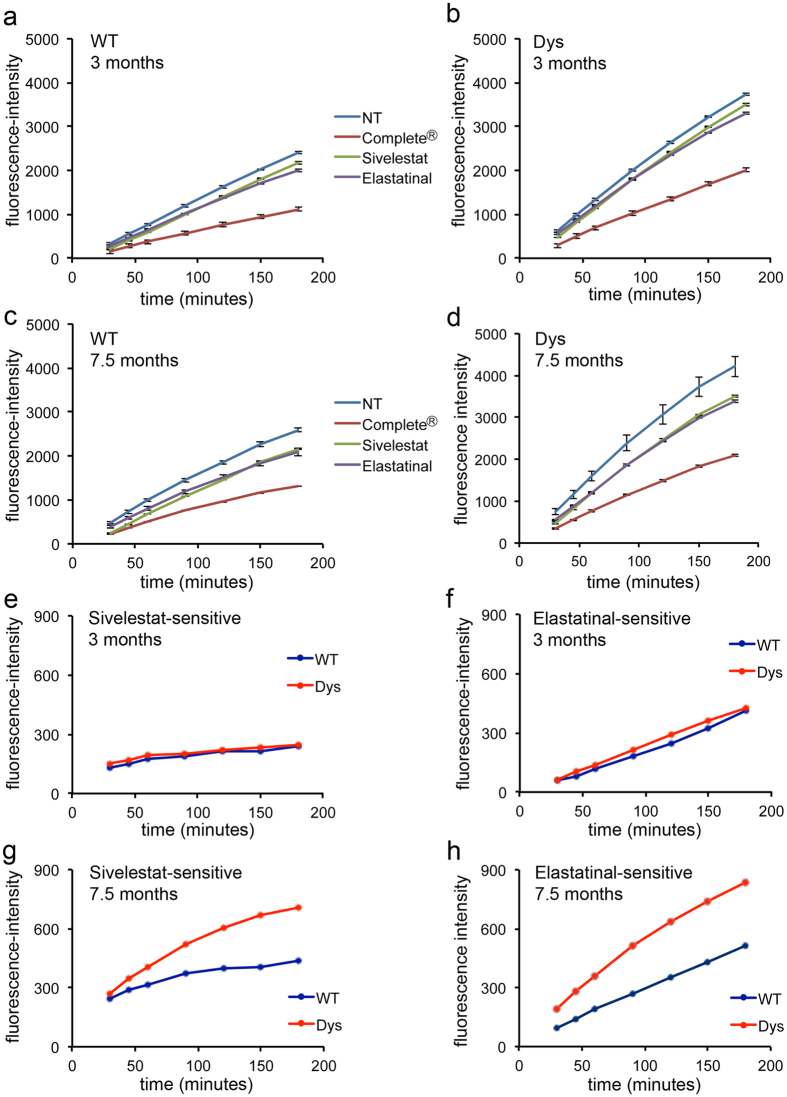
Elastase activity is increased in 7.5 month-old dystrophic muscle compared to age-matched wild type muscle.(a–d) Protease activity against the elastase substrate Suc-Ala-Ala-Ala-AMC was measured in the homogenate of wild type and dystrophic quadriceps muscles, in the presence/absence of various protease inhibitors, for each age and genotype group: 3 month old (a,b) and 7.5 month old (c,d), wild type (WT, a,c) and dystrophic (Dys, b,d) muscle. Kinetics of the accumulation of the reaction product over time (calculated as fluorescence emitted by each sample–fluorescence emitted by a blank containing only buffer and fluorogenic peptide) was plotted as the average of 3 technical replicates from 4 pooled biological replicates. Error bars are S.E.M. (e–h) The fraction of enzymatic activity against Suc-Ala-Ala-Ala-AMC that was sensitive to the elastase inhibitors Sivelestat (e,g) and elastatinal (f,h) was extracted from the averaged data shown in (a–d) and plotted as amount of reaction product over time: no difference in Sivelestat-sensitive or elastatinal-sensitive elastase activity is observed at 3 months of age between wild type and dystrophic muscle (e,f) while an increase in both Sivelestat-sensitive and elastatinal-sensitive elastase activity is observed at 7.5 months of age in dystrophic versus wild type muscle (g,h).